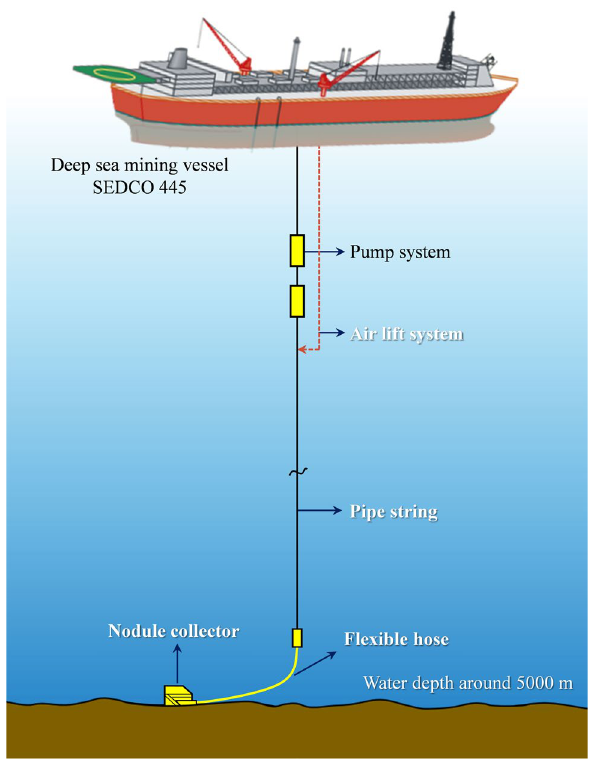
Fig. 13 Example mobile extraction techniques (modified from Bath